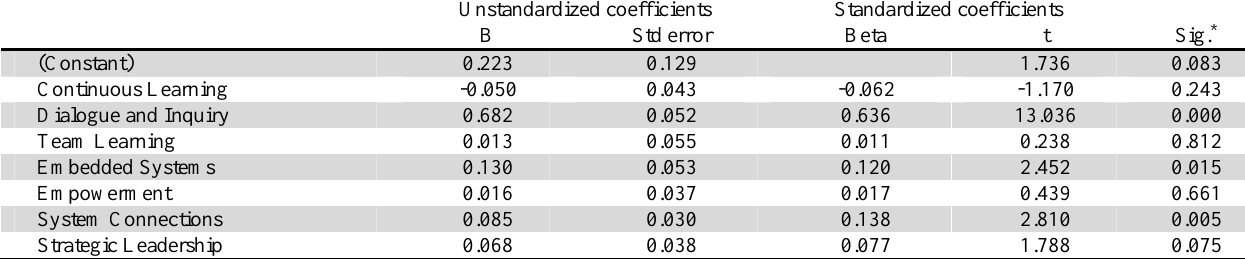
Regression equation- knowledge sharing and learning organization dimensions Unstandardized coefficients Standardized